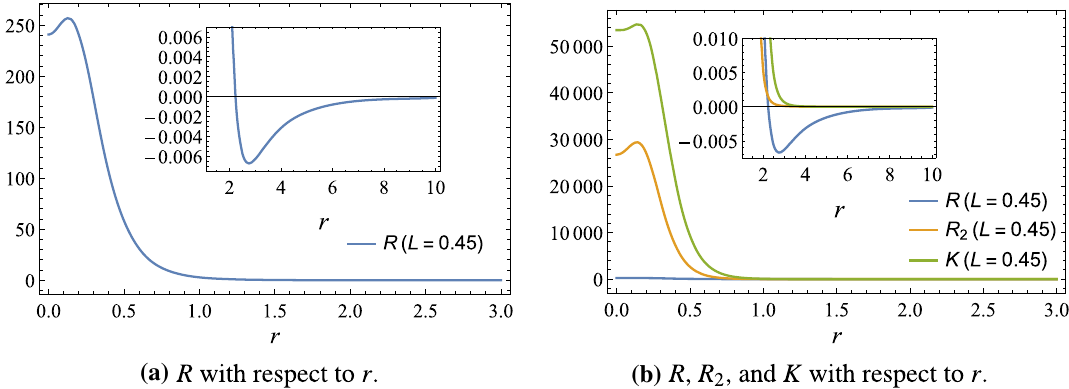
Fig. 2 R , R 2 , and K with respect to r for the case of N = 1 / 2, where L = 0 . 45 which satisfies L 2 < 1. Note that R is separated from the right graph and presented in the left graph in order to show its detail features